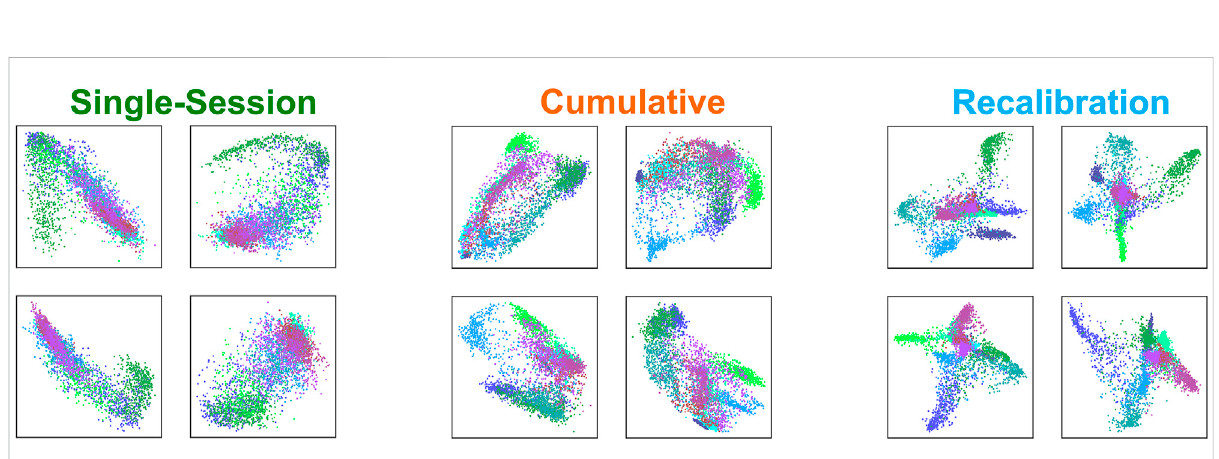
FIGURE 9 Each setof four panes represent an average latent dimension representation createdfrom thebottleneck layer ofthe encoder-decoder for the single-session,cumulative,and recalibration schemes. As therearefour dimensions oractivationsinthebottleneck, wedisplaythem plotted against each other for visualization. Each pose corresponds to a different color and separability is being shown between the various clusters of